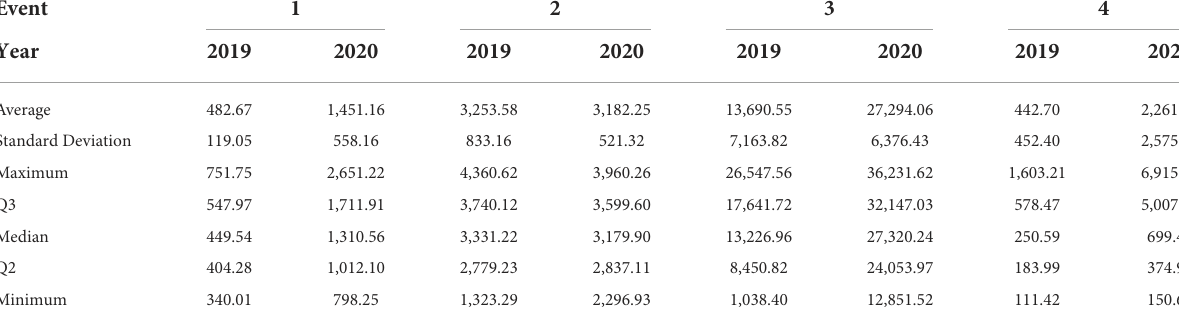
TABLE 3 Average monthly severity statistics (in R$), by event and year.